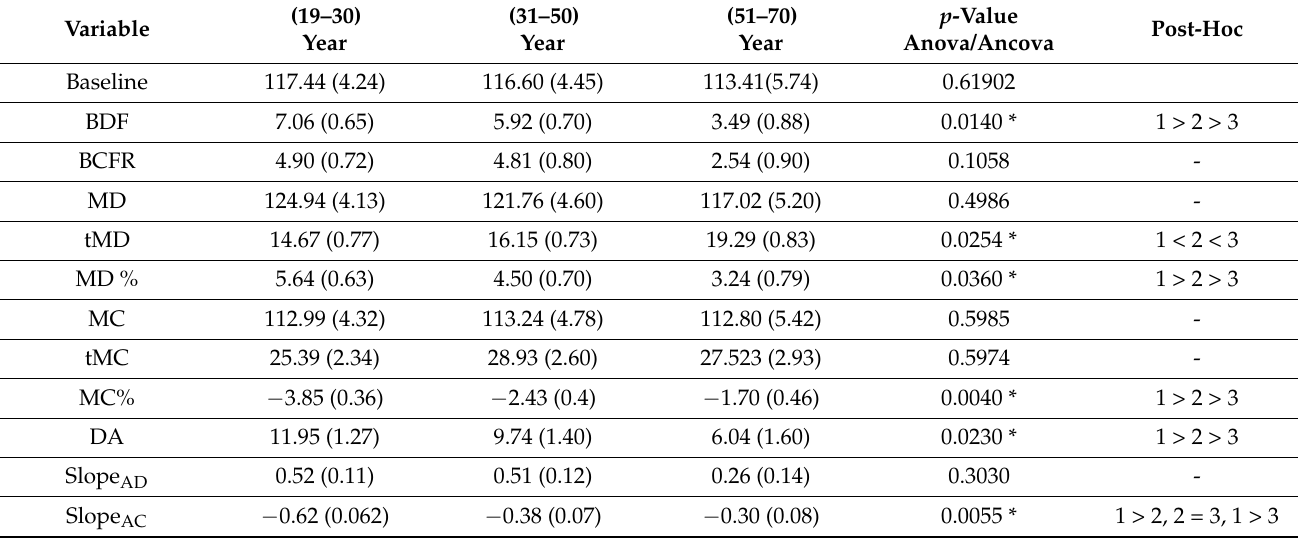
Table 2. Summary of retinal arterial vascular function parameters.